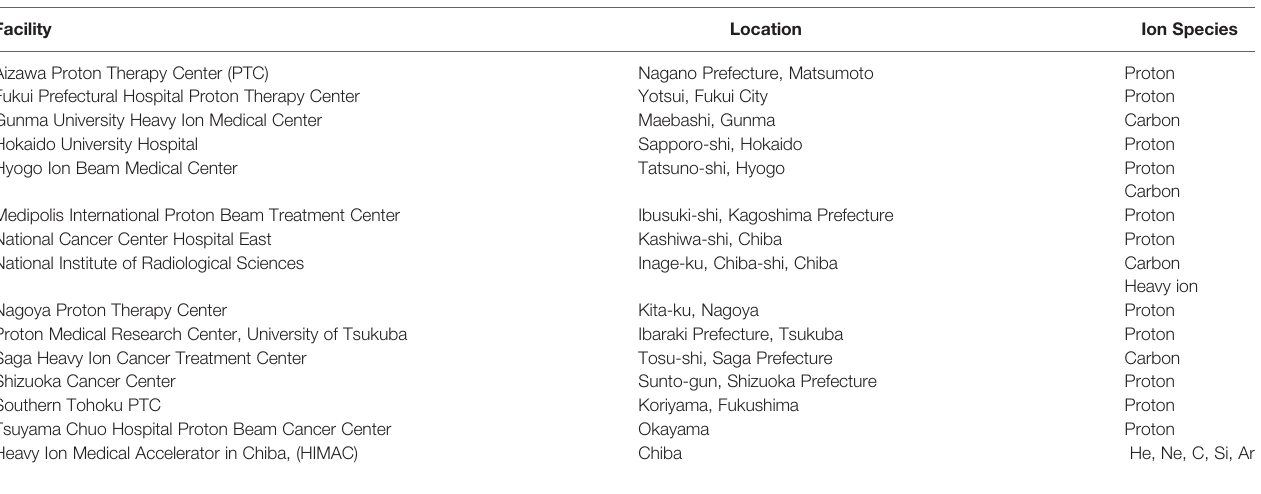
TABLE 2 | Particle therapy centers in